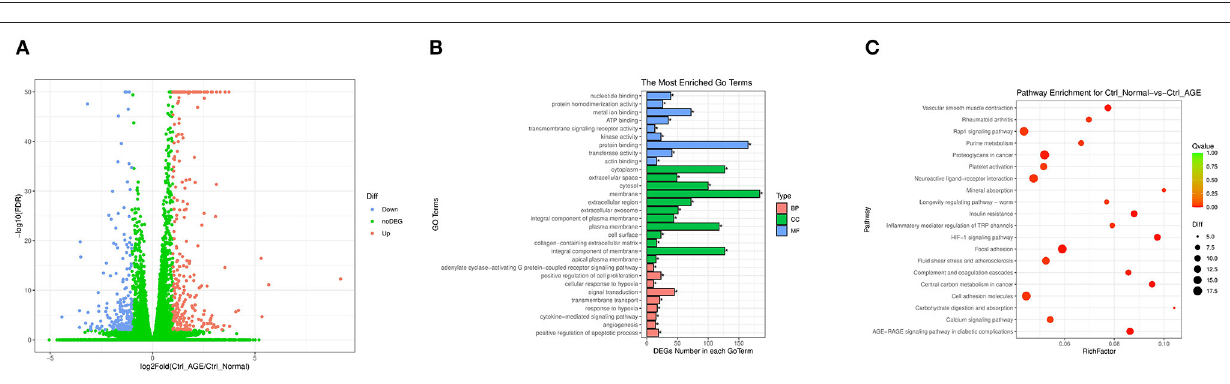
FIGURE 3 | (A) Cluster map and volcano map of differentially expressed genes in Ctrl group and AGEs group in HK-2 cells; (B) Gene ontology analysis enriches the number distribution position of differential genes; (C) Kyoto Encyclopedia of Genes and Gene Pathways (KEGG) analyzes metabolic pathways that are significantly enriched in differentially expressed genes in the Ctrl group and the AGEs